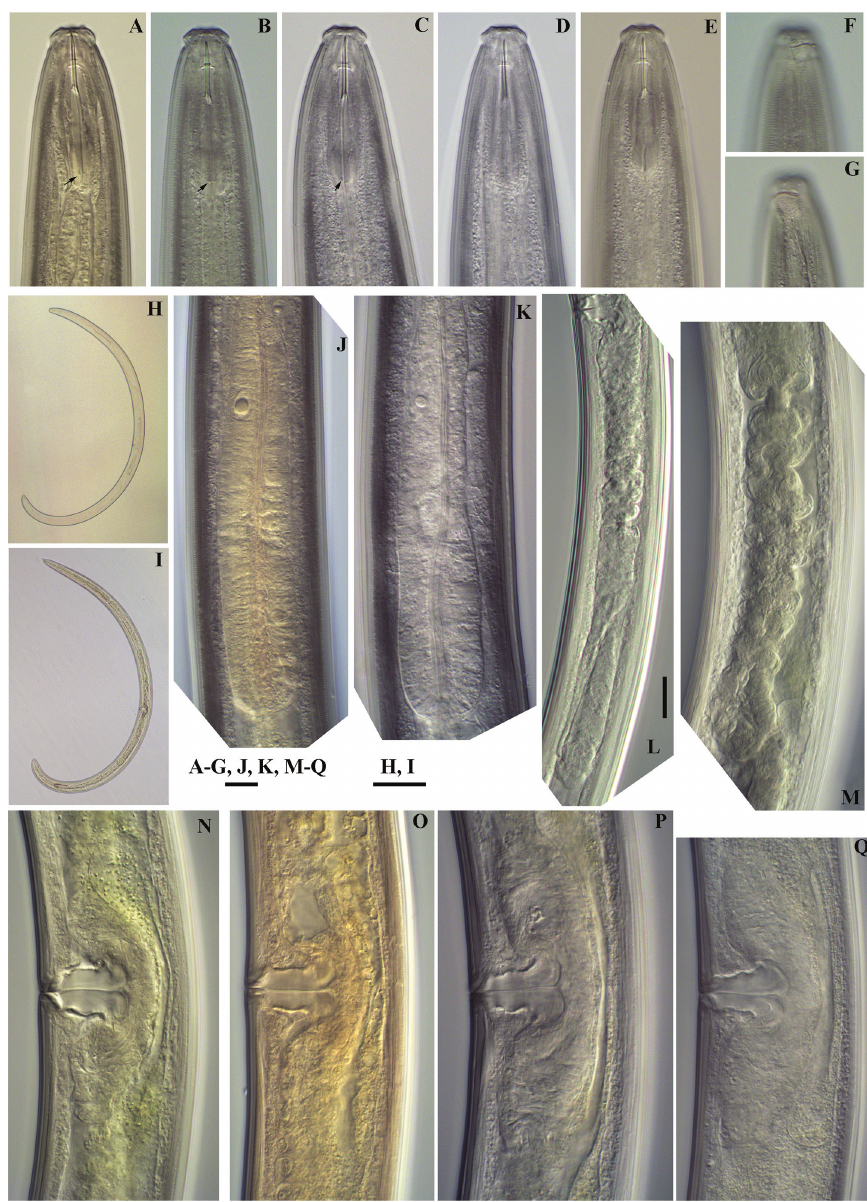
Figure 1. Enchodeloides signyensis (Loof, 1975), gen. n., comb. n. (= Enchodelus signyensis Loof, 1975). Female : A–E Anterior region ( A, B specimens from Livingston Island C, D, E specimens from King George Island), black arrows indicate the minute basal swellings F, G Amphideal fovea ( E specimen from Livingston Island G specimen from King George Island) H, I Entire body J, K Pharyngeal bulb ( J speci- men from Livingston Island K specimen from King George Island) L Posterior genital branch (specimen from Livingston Island) M Uterus (specimen from Livingston Island) N–Q Vulval regions ( N, O speci- mens from Livingston Island P, Q specimens from King George Island). Scale bars: 10 µm ( A–G, J, K, M–Q ); 200 µm ( H, I ); 20 µm ( L